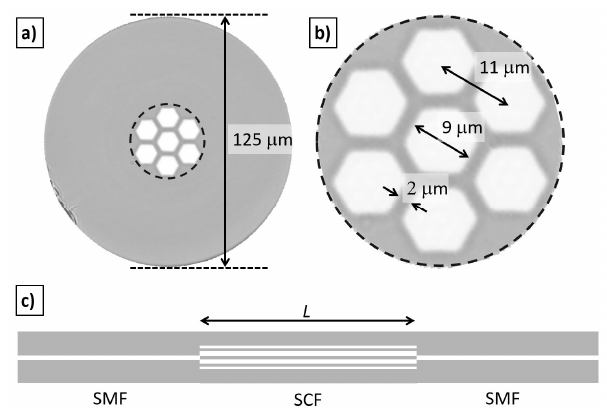
Figure 3. Transversal section of the SCF used in this work. ( a ) The fiber diameter is 125 μ m, and the hexagonal cores are arranged in a honeycomb ‐ like distribution. ( b ) Detail of the fiber cores showing a separation of 11 μ m between center cores and a core size of 9 μ m measured between opposite facets. ( c ) Schematic of the transversal section of the fabricated SMF ‐ SCF ‐ SMF devices.